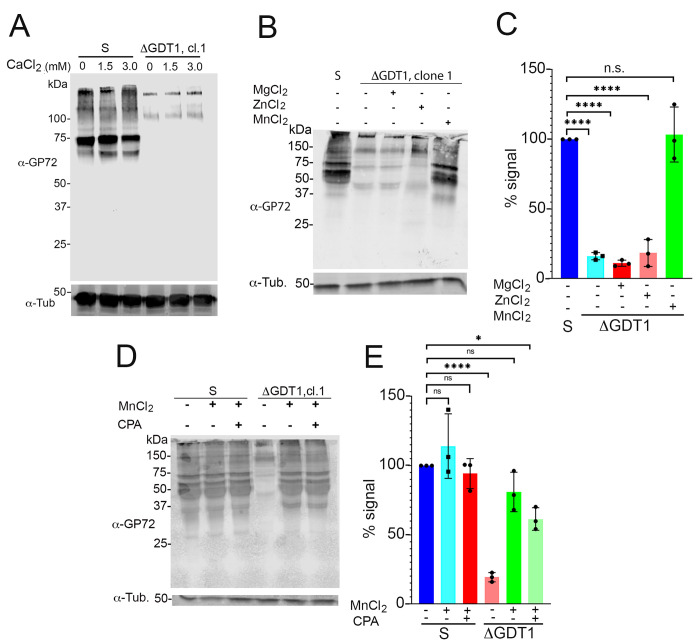
Lack of rescue of glycosylation defect by CaCl2, MgCl2, and ZnCl2 and effect of cyclopiazonic acid.(A) Western blot analysis using WIC 29.26 antibody in epimastigotes of control (S) and TcGDT1-KO clone 1, untreated or treated with indicated concentrations of CaCl2 for a period of 24 hours before protein extraction and SDS-PAGE. The 72 kDa band corresponding to GP72 and the smearing of the lanes of control (S) disappear or are greatly reduced in the TcGDT1-KO clone 1 untreated with CaCl2. This band and the smearing in lanes do not return to the control level despite treatment with increasing CaCl2 concentrations. Anti-tubulin (Tub) was used as loading control. (B) Western blot analysis using WIC29.26 antibody in epimastigotes of control (S) or TcGDT1-KO clones either untreated or treated with 20 μM MgCl2, 20 μM ZnCl2 or 20 μM MnCl2 before protein extraction and SDS-PAGE. The 72 kDa band corresponding to GP72 and the smearing of the lanes of control (S) disappear in the TcGDT1-KO clone 1 untreated with MnCl2. The bands gradually return to the control level by treatment with MnCl2. However, treatment with MgCl2 or ZnCl2 does not cause the bands to reappear. Anti-tubulin (Tub) was used as loading control. (C) the intensity of bands in (B) was quantified by normalizing GP72 signal to the tubulin signal and expressed graphically as a percentage of signal from the control. Values are means ± s.d., n = 3, **p < 0.01; ***p < 0.005; ****p < 0.0001. Statistical analyses were performed using one-way ANOVA and Turkey’s multiple comparisons test. (D) Western blot analysis using WIC 29.26 antibody in epimastigotes of control (S) or TcGDT1-KO clones either untreated or treated with 20 μM MnCl2 and 100 μM cyclopiazonic acid before protein extraction and SDS-PAGE. The 72 kDa band corresponding to GP72 and the smearing of the lanes of control (S) disappear in the TcGDT1-KO clone 1 untreated with MnCl2. The bands gradually return to the control level by treatment with MnCl2. Additionally, treatment with CPA does not prevent the bands from reappearing. Anti-tubulin (Tub) was used as loading control. (E) The intensity of bands in (D) was quantified by normalizing GP72 signal to the tubulin signal and expressed graphically as a percentage of signal from the control. Values are means ± s.d., n = 3, *p < 0.05, **p < 0.01; ***p < 0.005; ****p < 0.0001. Statistical analyses were performed using one-way ANOVA and Turkey’s multiple comparisons test.